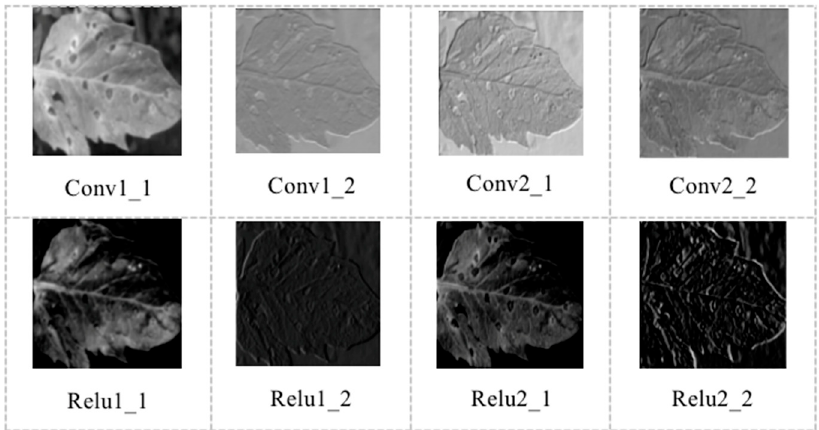
Figure 9. Output features of Conv1-2 and Relu1-2 layers of tomato diseases.